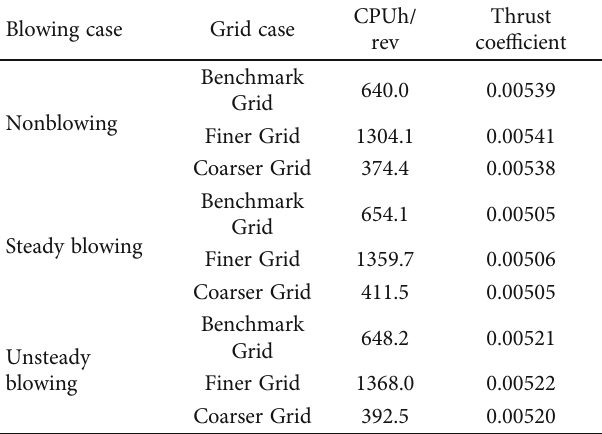
Table 2: Comparison of the computational cost, thrust coe ffi cient of three grid